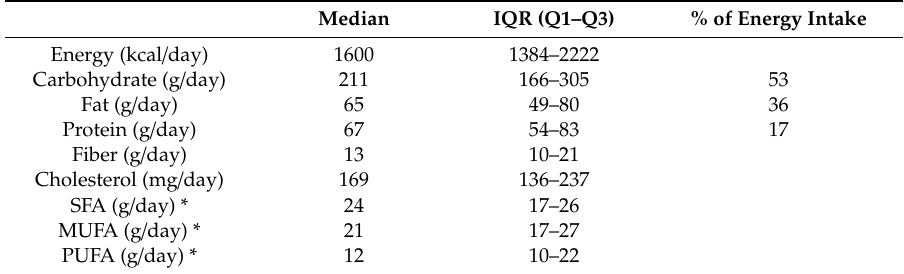
Table 2. Energy and macronutrient intakes of polypectomy patients based on the food-frequency questionnaire ( n = 30; male = 14, female =